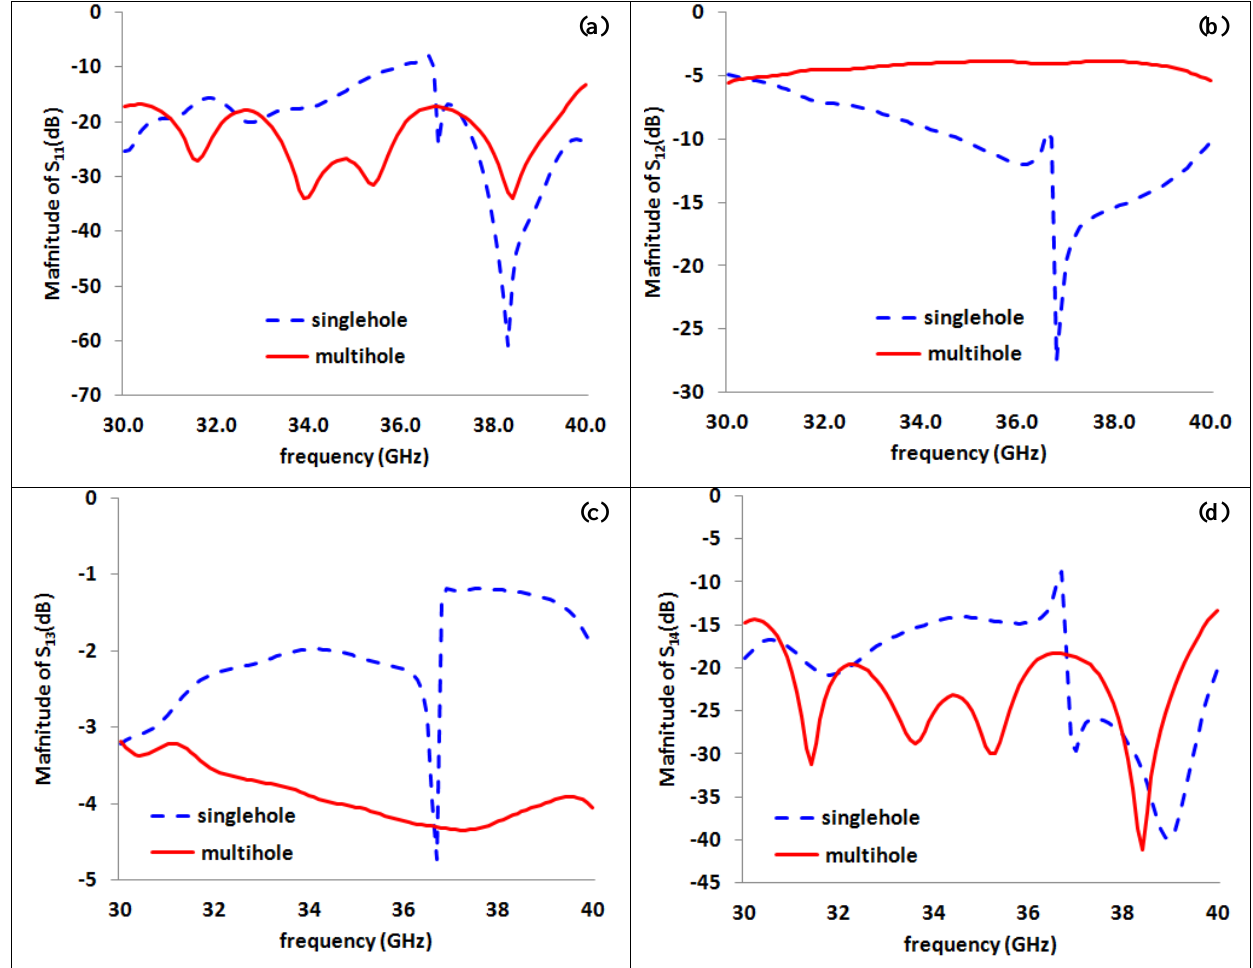
Figure 3. Comparison between suggested model of coupler in presence and absence of the vias (a)S11 or reflection factor (b) S12 or through factor (c) S13 or coupling factor (d) S14 or Isolation